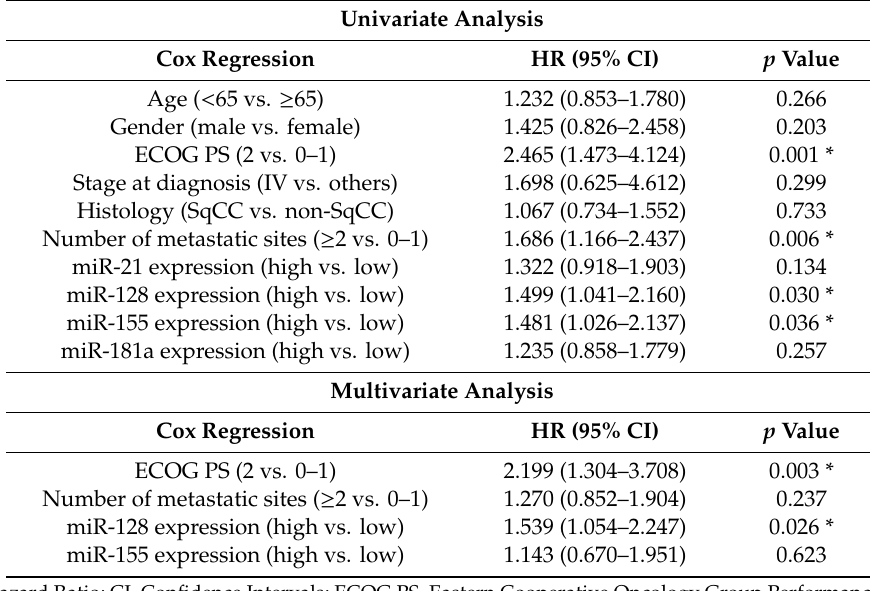
Table 3. Univariate and multivariate Cox regression analysis for overall survival in NSCLC